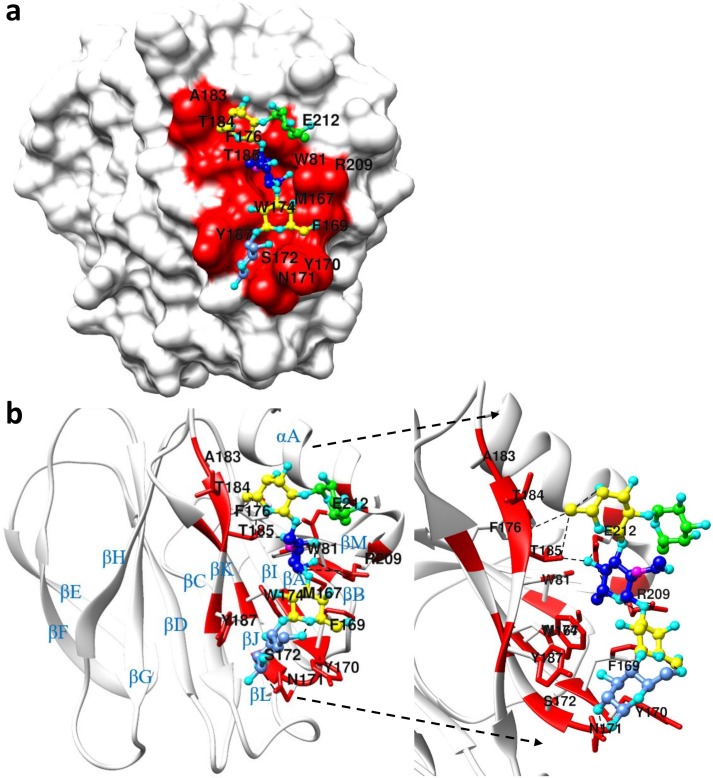
Crystal structure of LNFP I-P[6] complex.(a) The surface model of LNFP I-P[6] complex [PDB: 6OAI]. (b): Ribbon diagram shows the LNFP I-P[6] VP8* complex. The right panel in (b) highlights the binding pocket of P[6] VP8* in recognizing LNFP I. Red represents the binding interface. Different colors were used to represent different carbohydrate moiety of the ligand: Green colors the secretor fucose residue, yellow colors the Galactose residue, blue colors the N-Acetylglucosamine residue, cornflower blue colors the Glucose residue.